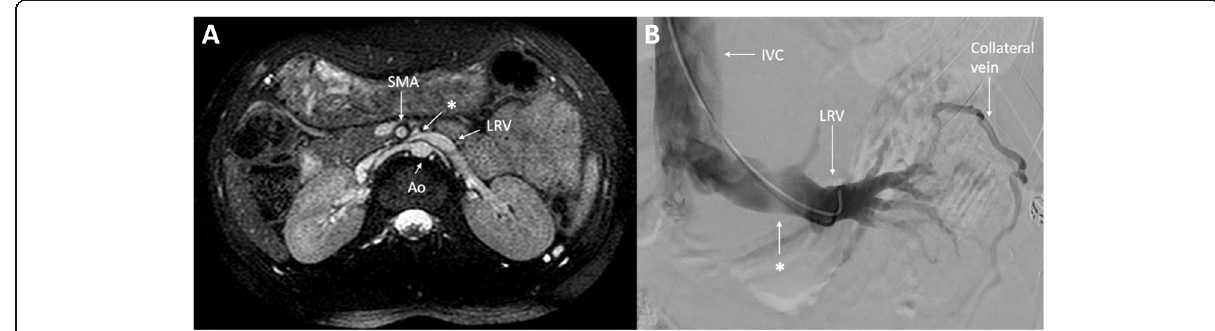
Fig. 1 A Magnetic resonance imaging of the kidneys and renal veins. Note the narrowing/pinching (*) between the SMA and the anterior aorta in the left renal vein (LRV) with a dilation proximal to the narrowing. B Venogram of the left renal vein. Note the remarkable low contrast density (*) before entry into the IVC, due to compression by the SMA and the anterior aorta. The perinephric vein of collateral drainage, due to partial obstruction and flow resistance, is abnormally observed. Ao, aorta; SMA, superior mesenteric artery; IVC, inferior vena cava; LRV, left renal